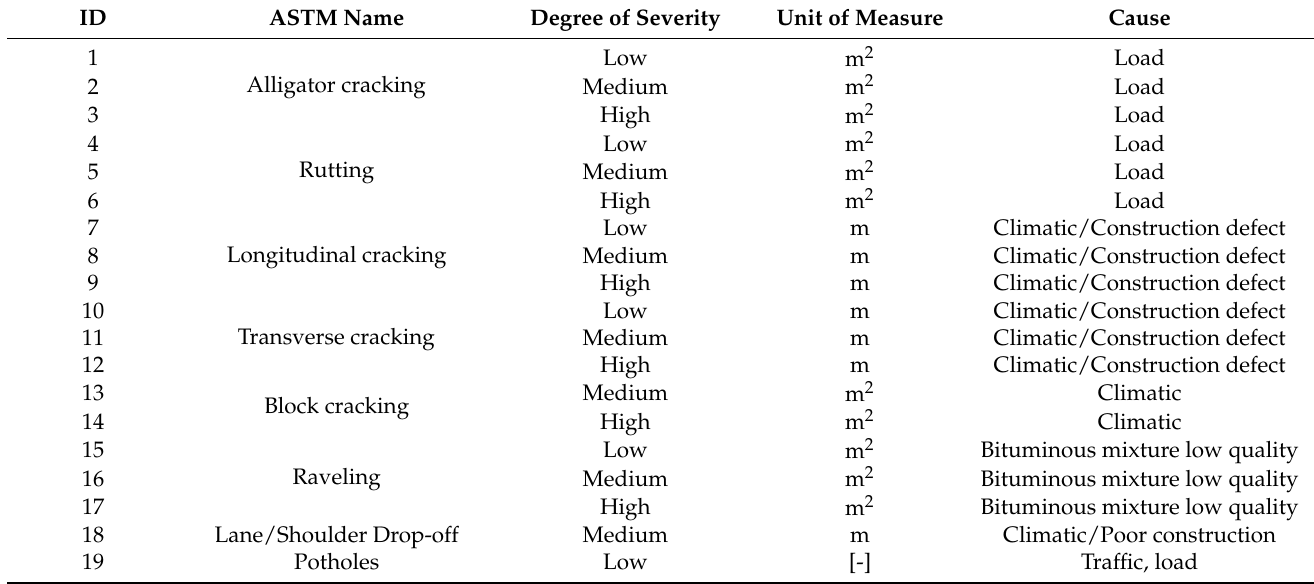
Table 1. Road surface defects considered in the development of the model proposed in this